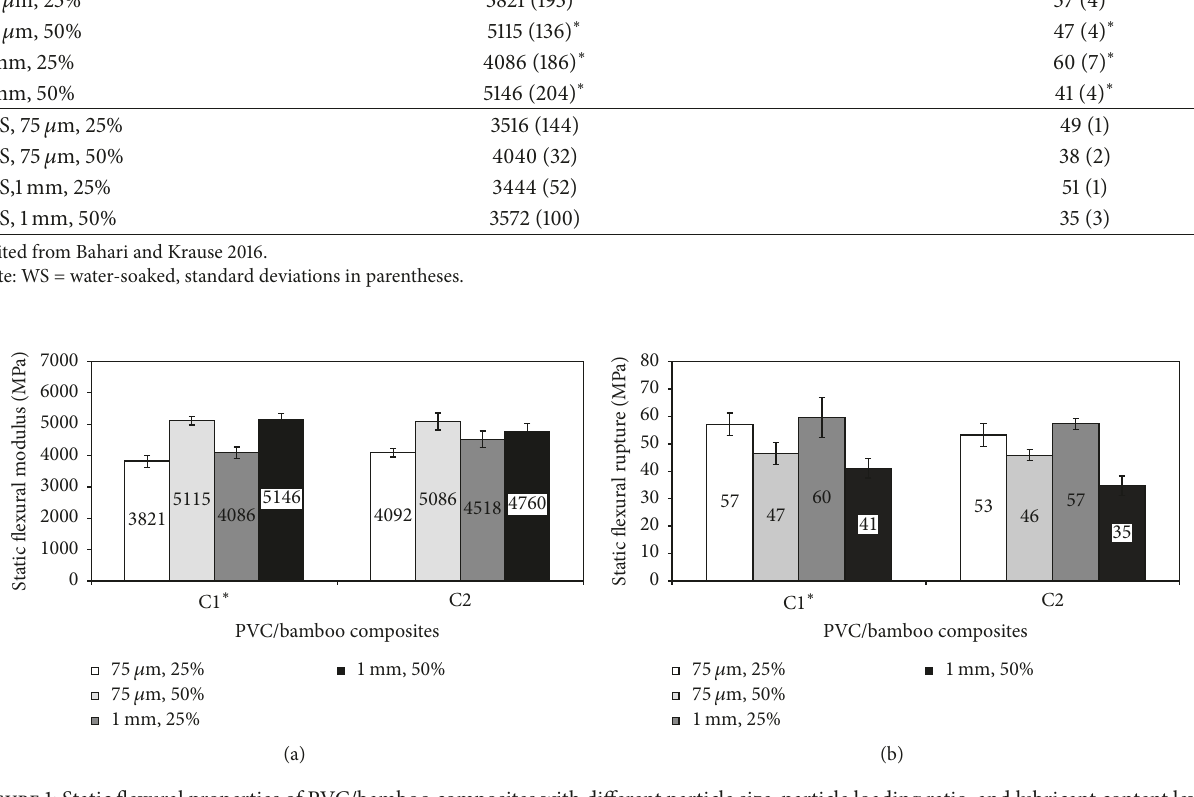
Figure 1: Static flexural properties of PVC/bamboo composites with different particle size, particle loading ratio, and lubricant content level; (a) mean static flexural modulus and (b) mean static flexural rupture (pure PVC has values 2866 MPa and 73 MPa for modulus and rupture, resp.) ( ∗ Bahari and Krause